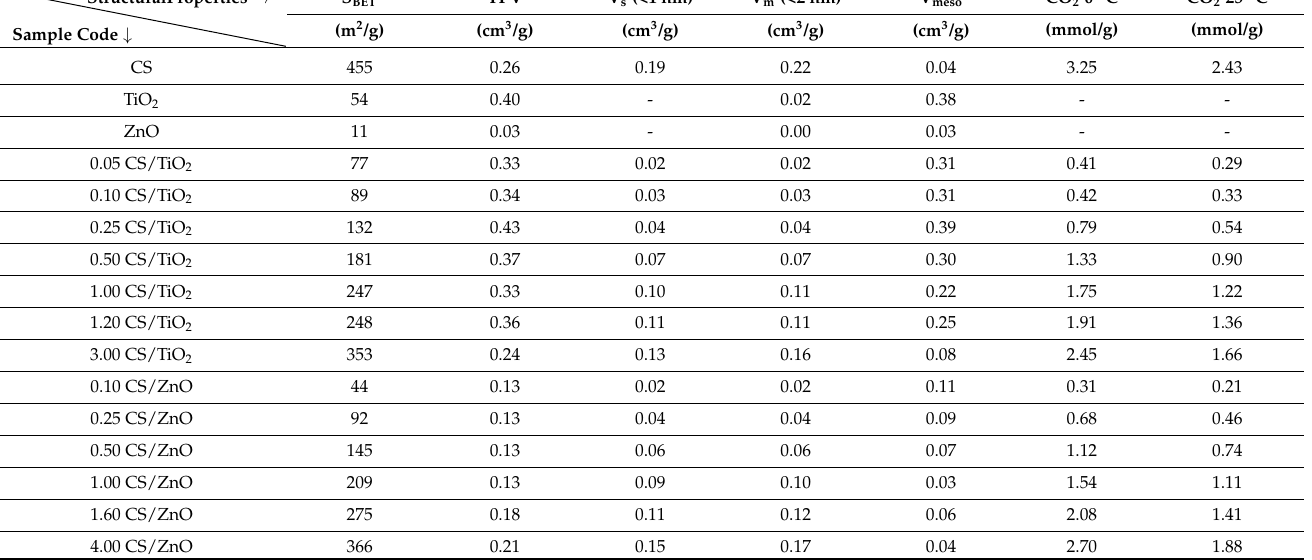
Table 1. Textural parameters and CO 2 sorption capacities for the activated carbon